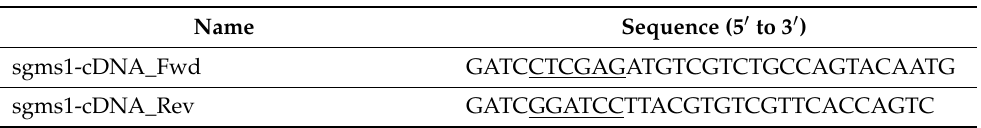
Table 4. sgms1 cDNA Primers. Restriction enzyme sites XhoI (Fwd) and BamHI (Rev) used for cloning are